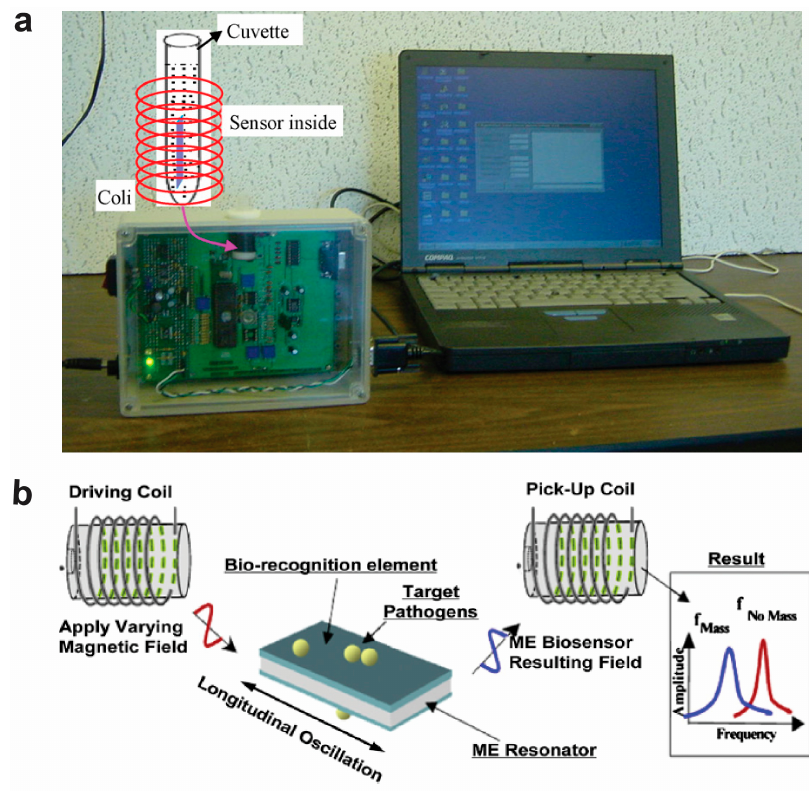
Figure 3. Wireless magnetoelastic bioelectronic sensors. ( a ) Experimental setup about microprocessor-based electronic box. Reprinted from [66]. Copyright (2010), with permission from Elsevier. ( b ) Operating principle of the magnetoelastic biosensor. Reprinted from [68]. Copyright (2012), with permission from Elsevier.